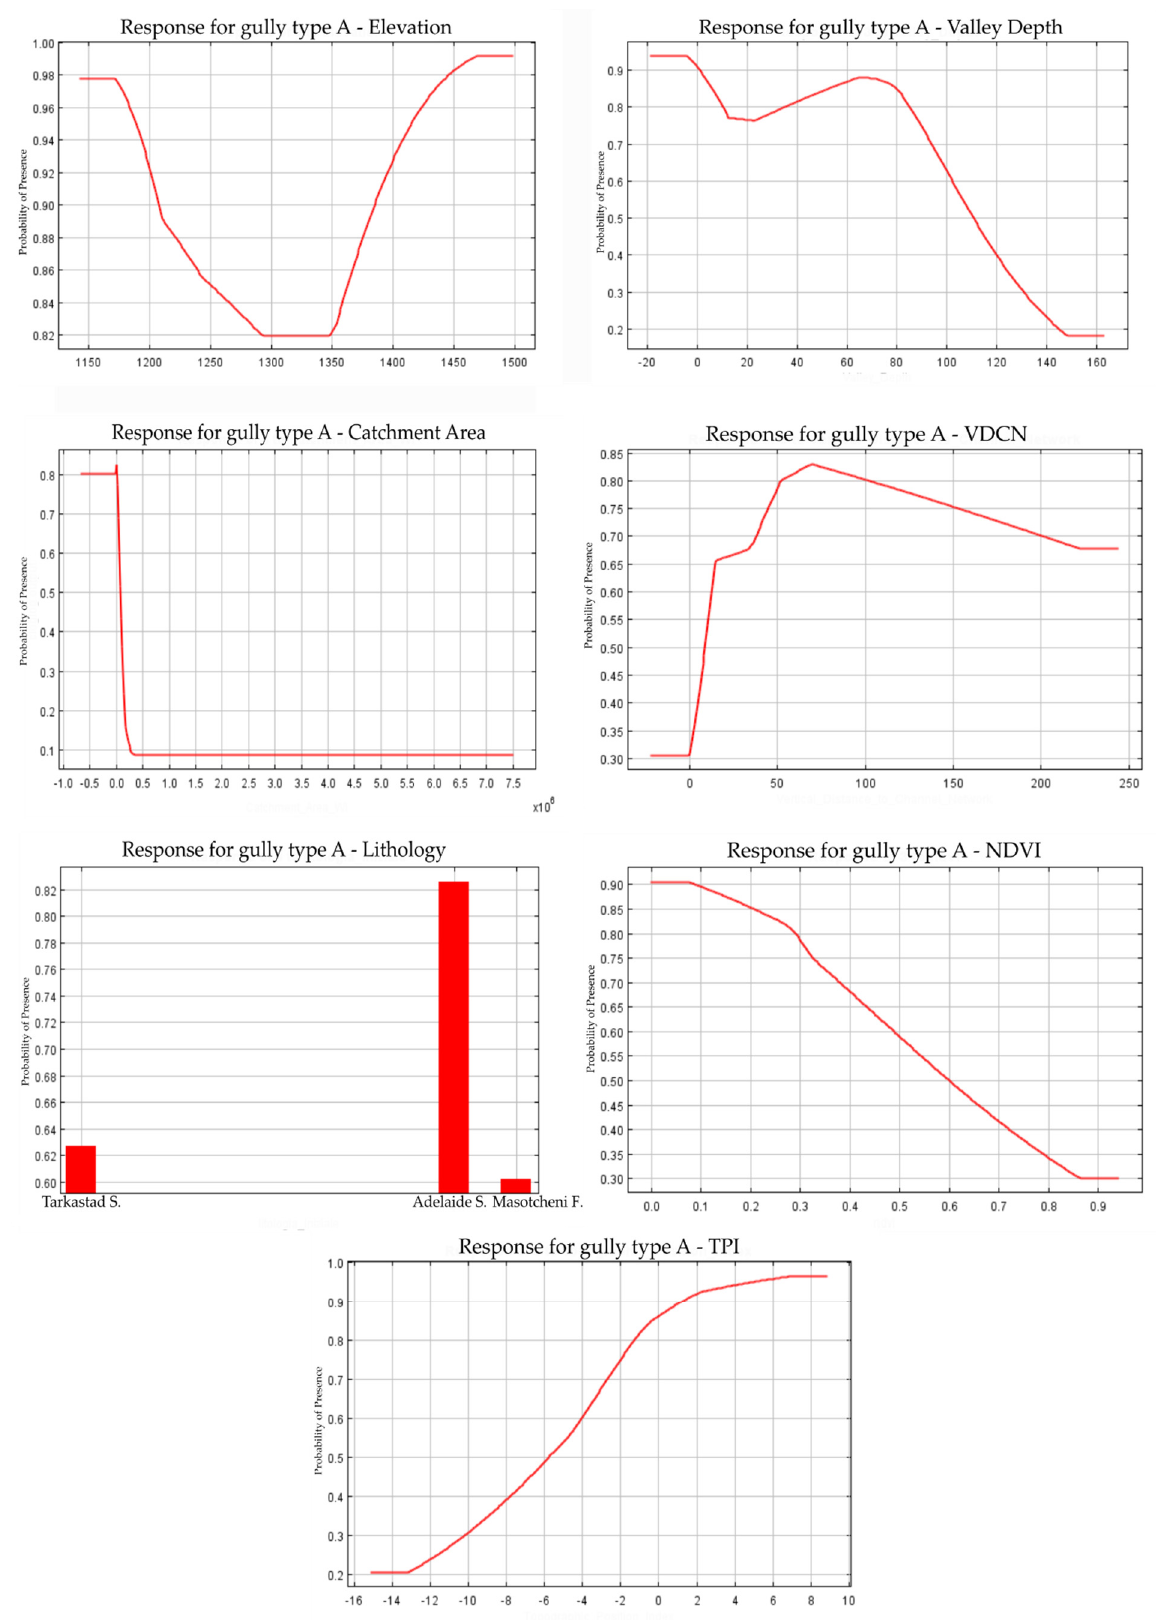
Figure 5. Variable importance for gully type A.